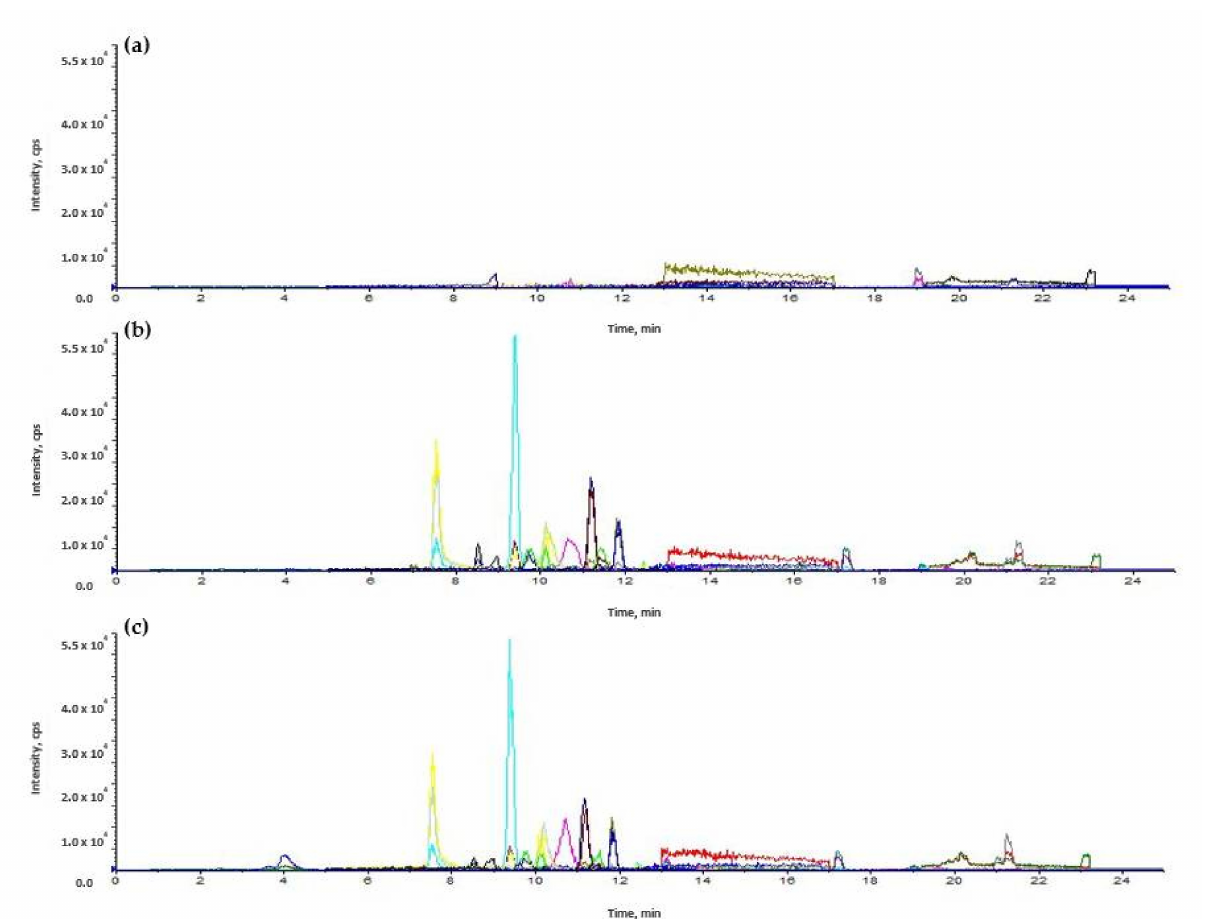
Figure 6. Representative multiple-reaction monitoring chromatograms of: ( a ) blank; ( b ) middle concentration standard; ( c ) middle concentration